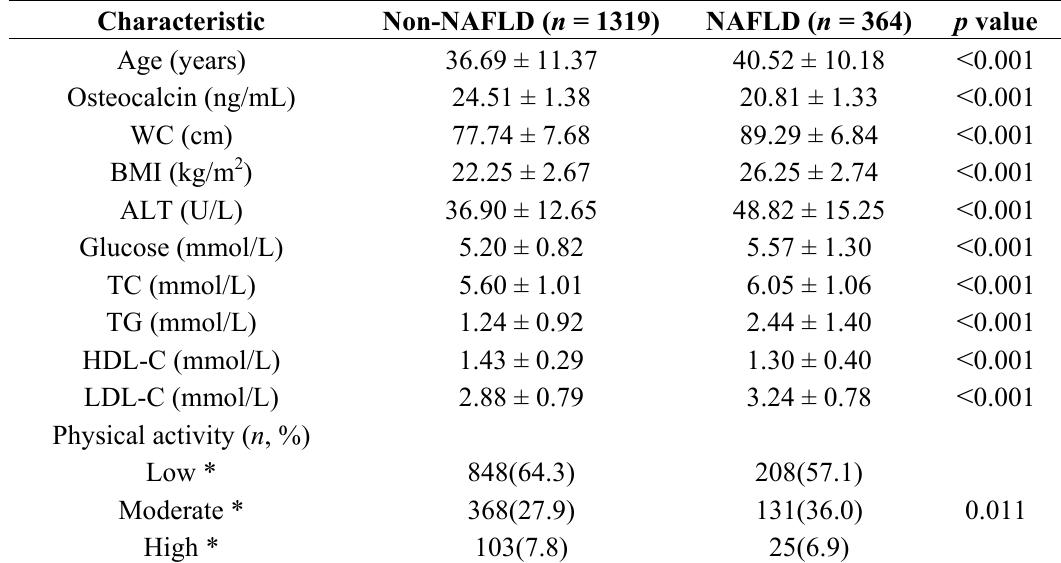
Table 1. Baseline characteristics of the subjects in non-NAFLD and non-alcoholic fatty liver disease (NAFLD) groups.